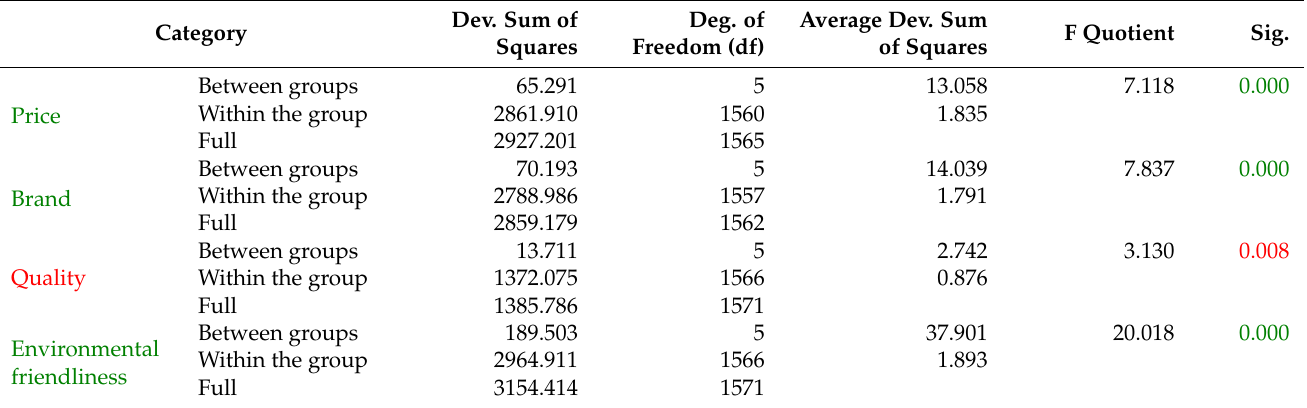
Table 7. ANOVA test of correlations between the perception of product characteristics and age by